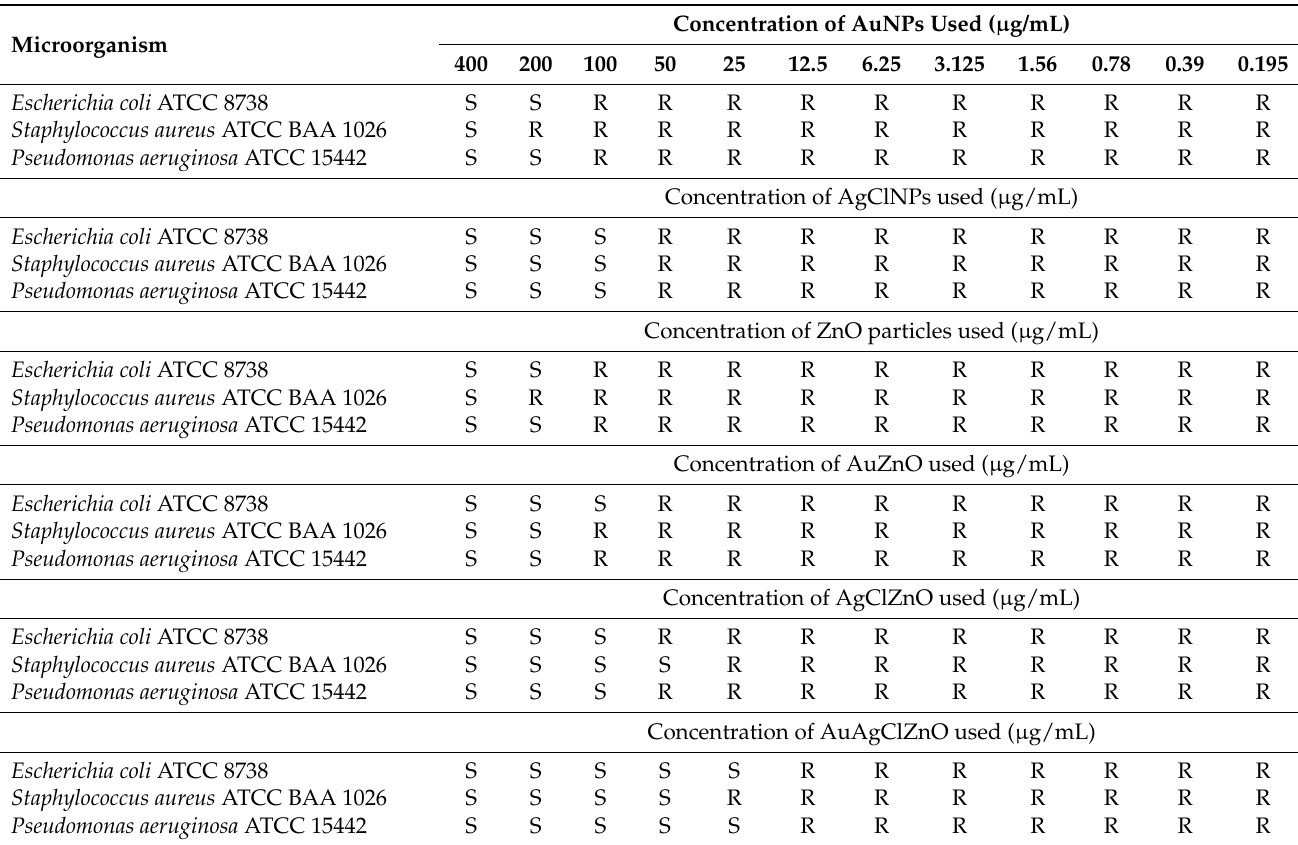
Table 2. Antimicrobial susceptibility of the microorganisms to burdock-derived particles. Microorganism